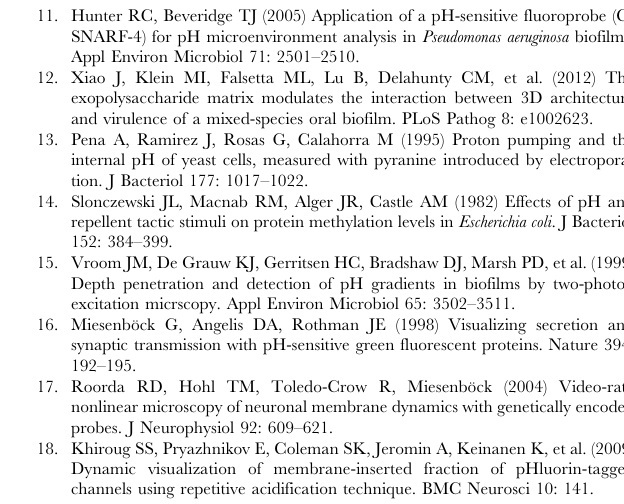
Figure S1 Schematic drawing of construction of pFW5- ldh p -leading sequence - gfp -linker- spaP